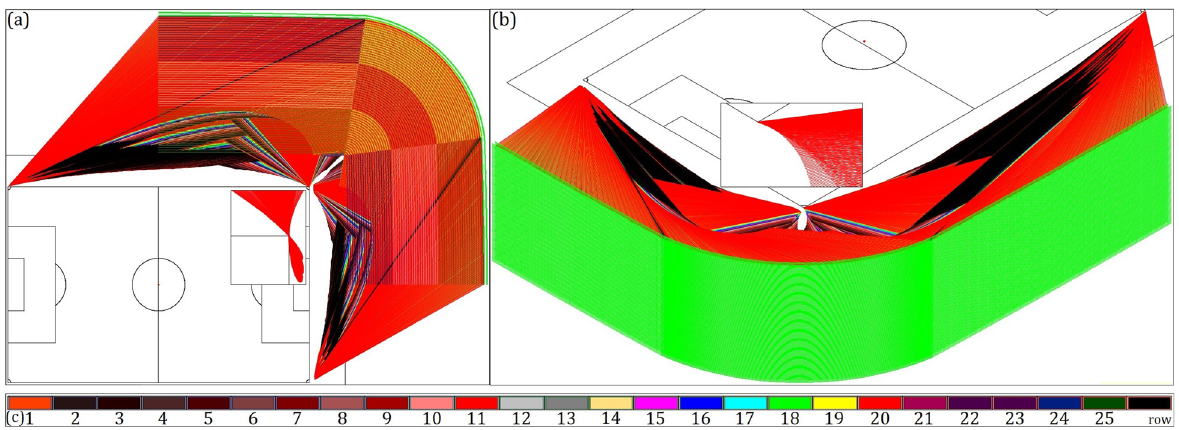
Figure 12: ILSF lines ( plotted for the focuses FL , FR ) for all eye points in all stands for the values of H n , H m , H k determined by the LSC algorithm for focuses ( a ) FO , ( b ) FL , FR , ( c ) color